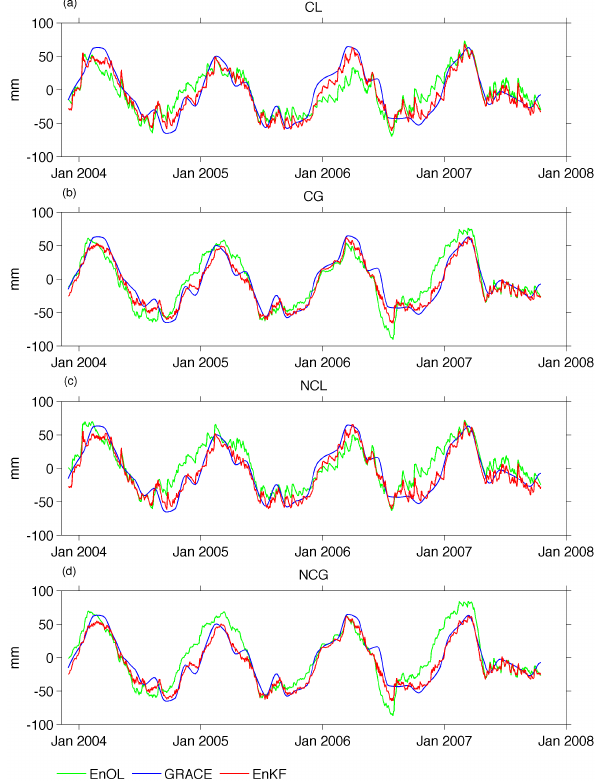
Figure 5. Area-averaged mean terrestrial water storage (TWS) over the Rhine River basin from the EnOL, EnKF, and GRACE observa- tions in four different scenarios (CL: calibrated parameters with lo- cal forcing data; CG: calibrated parameters with global forcing data; NCL: non-calibrated parameters with local forcing data; NCG: non- calibrated parameters with global forcing